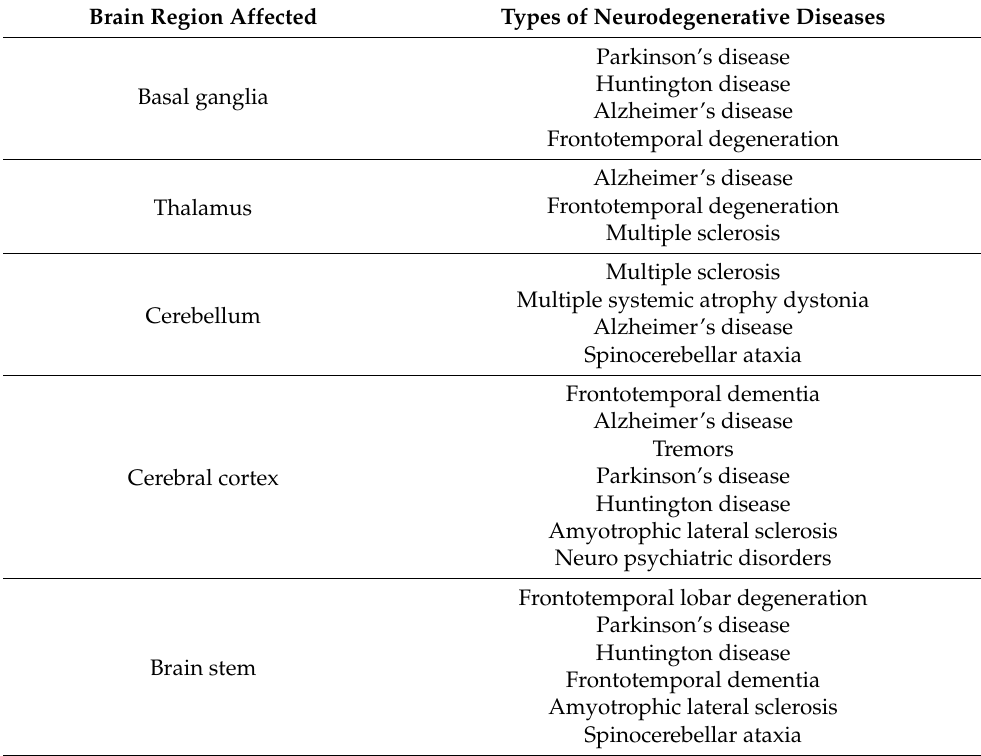
Table 1. Types of neurodegenerative diseases according to the brain region